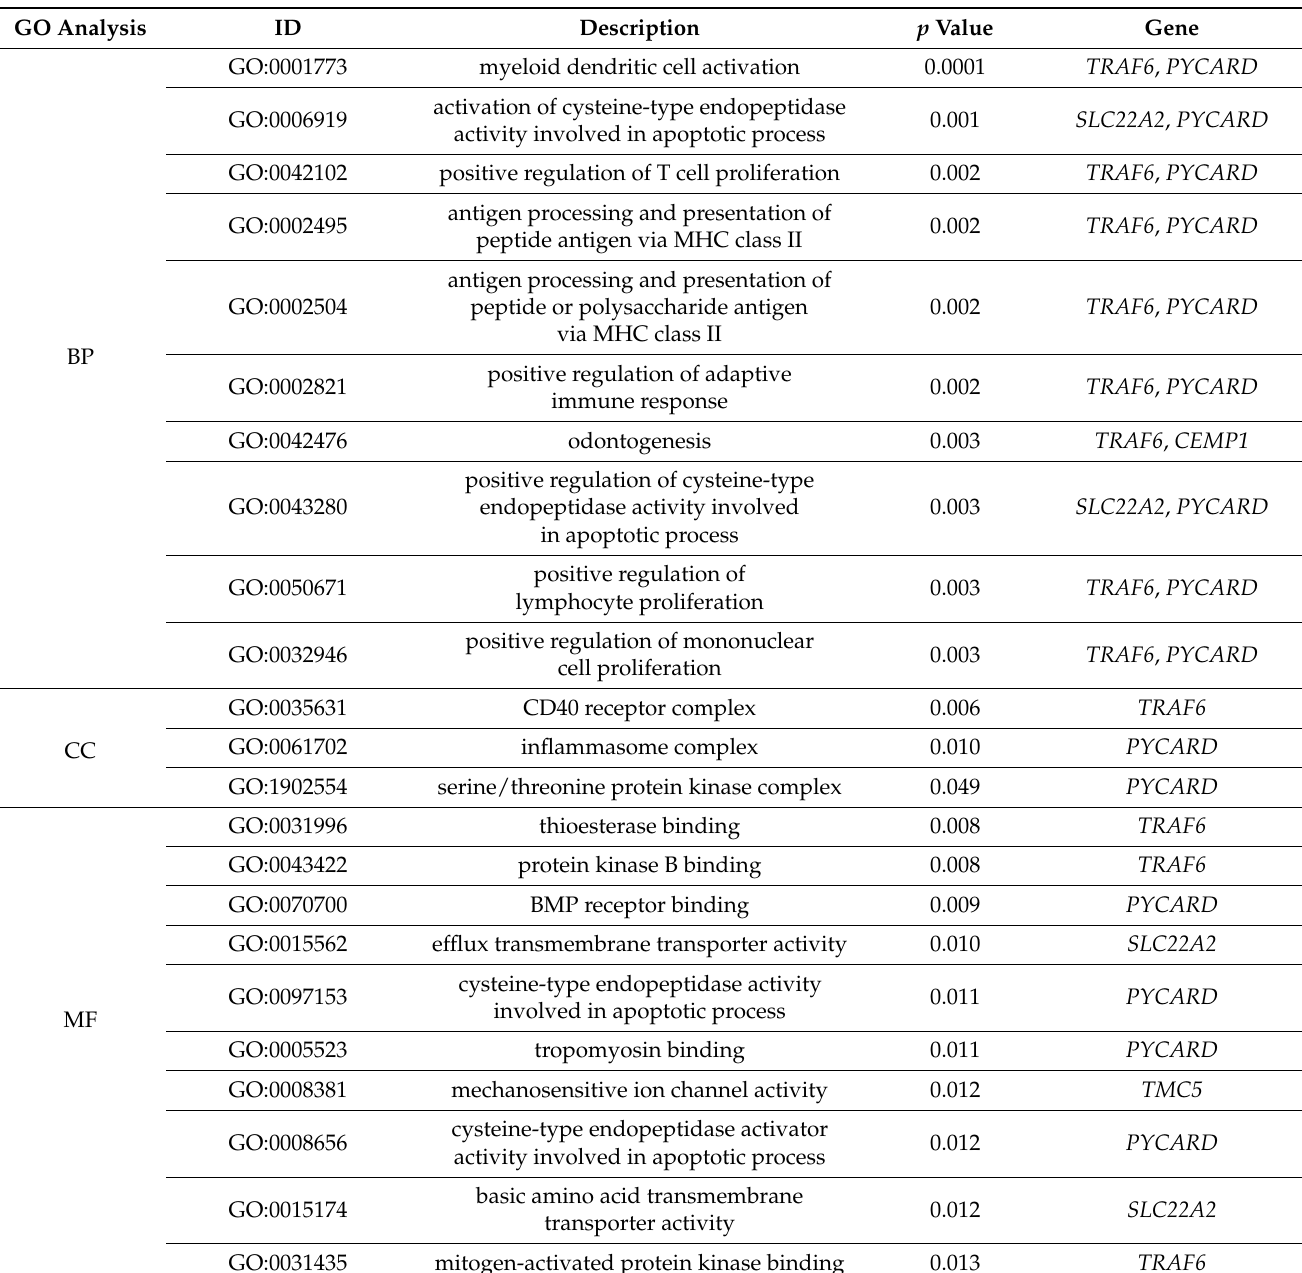
Table 2. GO enrichment